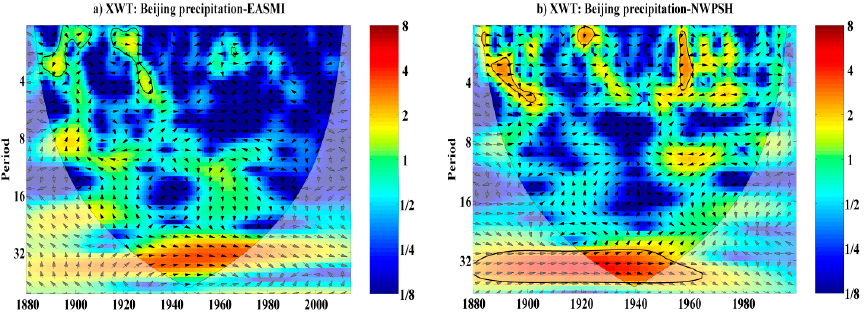
Figure 3. Cross Wavelet Spectrum between EASMI ( a ) and NWPSH ( b ) and the precipitation of the Beijing area.